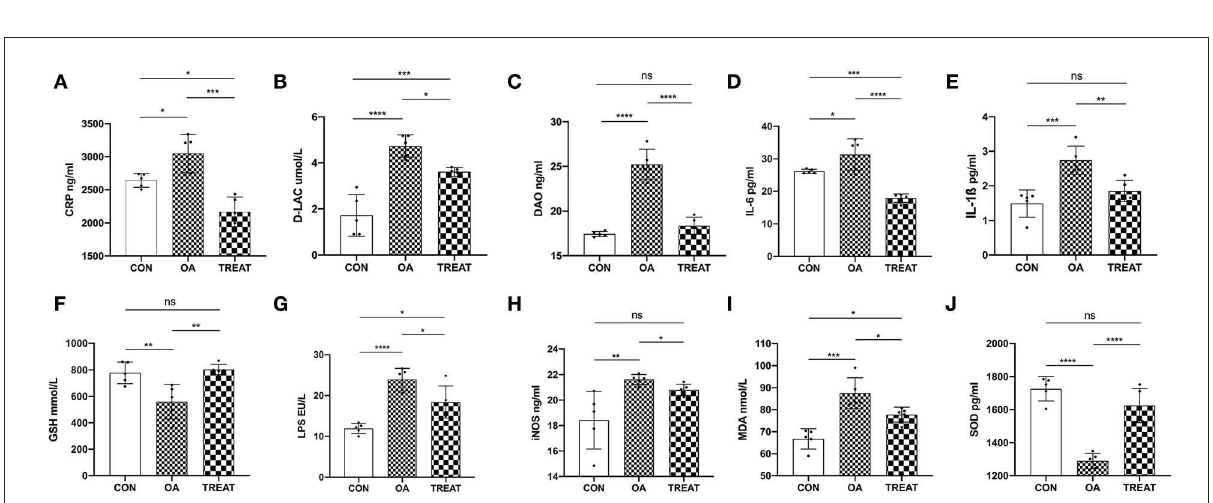
FIGURE2 Effects of the oral administration of live combined Bacillus subtilis and Enterococcus faecium on serum intestinal function parameters, antioxidant parameters, and inflammatory cytokine and LPS levels in OA-induced rats with colitis. (A) CRP. (B) D-LAC. (C) DAO. (D) IL-6. (E)